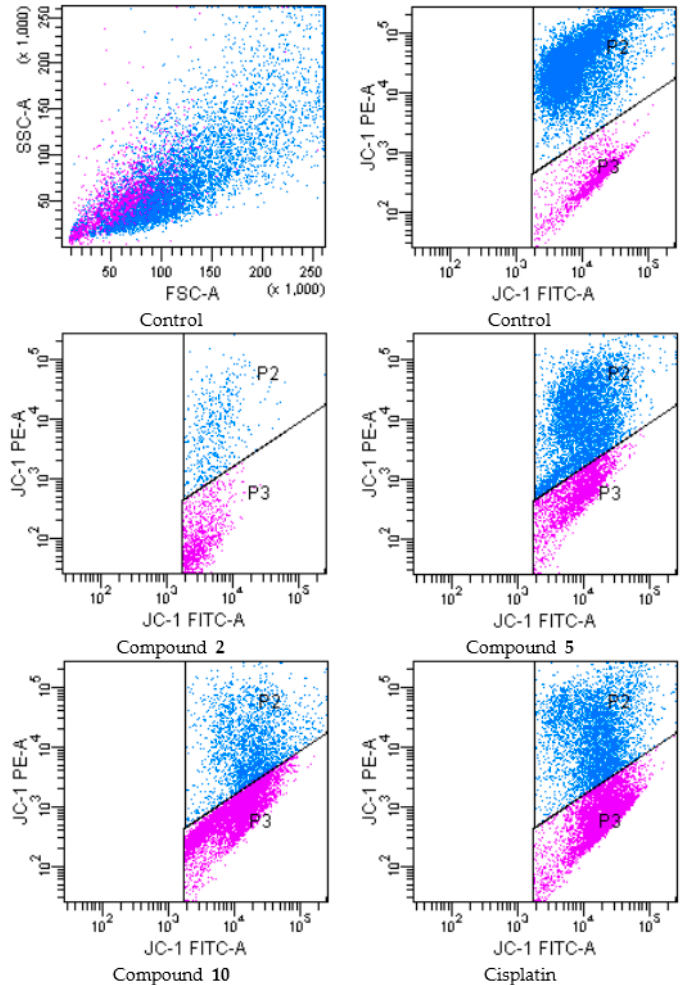
Figure 4. The reduction of the mitochondrial membrane potential in A549 cell line by the compounds. The cells treated or untreated with the IC 50 doses of the compounds for 24 h were stained with the mitochondrial-selectivite JC-1 dye and analyzed by flow cytometry. P2: mitochondrial membrane polarized cells, P3: mitochondrial membrane depolarized cells.